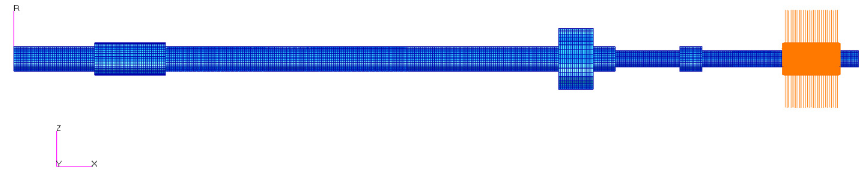
Figure 12. Load on rotor thread.